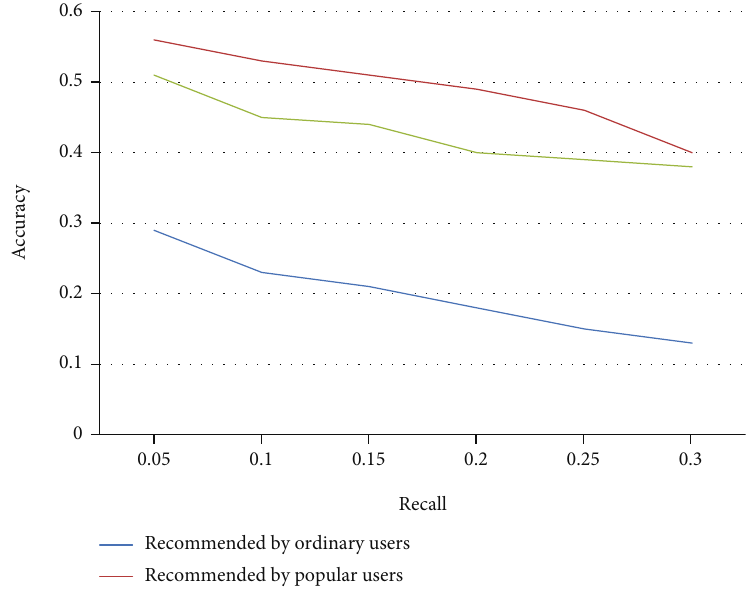
Figure 11: Precision/recall curves for three recommendation